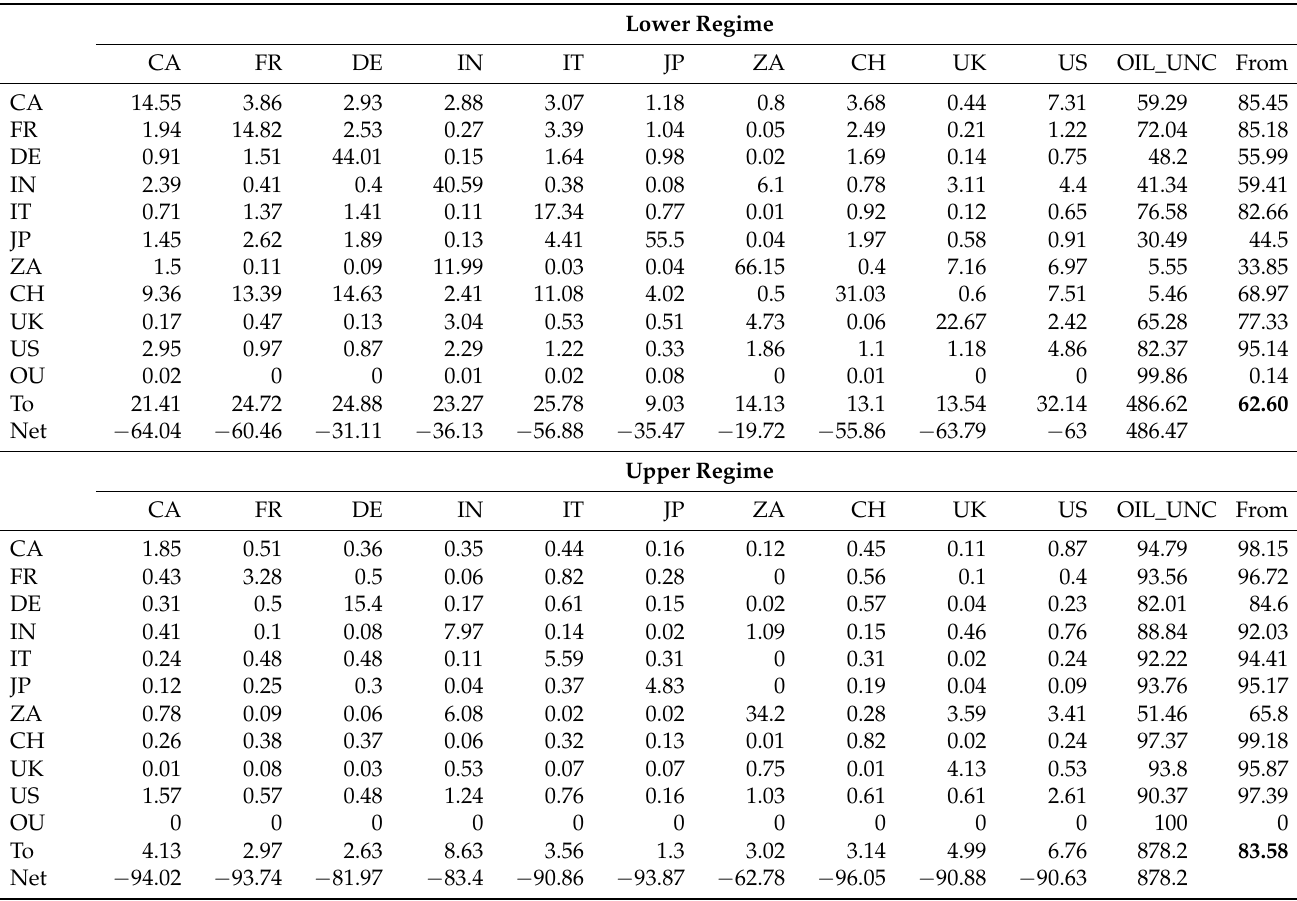
Table 2. Regime dependent connectedness based on STVAR model. Lower